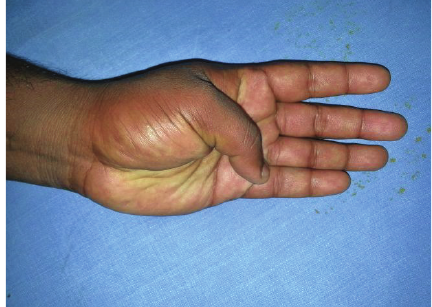
Figure 8: Follow-up, normal pulp pinch. Table 1: Fitoussi et al. criteria for flexor pollicis longus